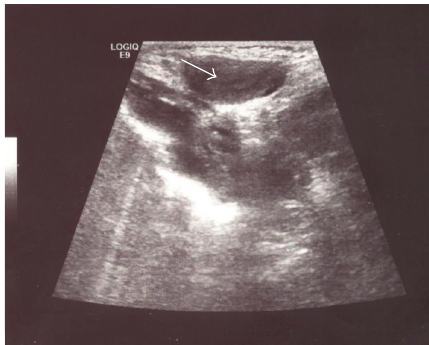
Figure 1: Ultrasonography image: a solid mass in right inguinal channel with a clearly visible endometrial lining.